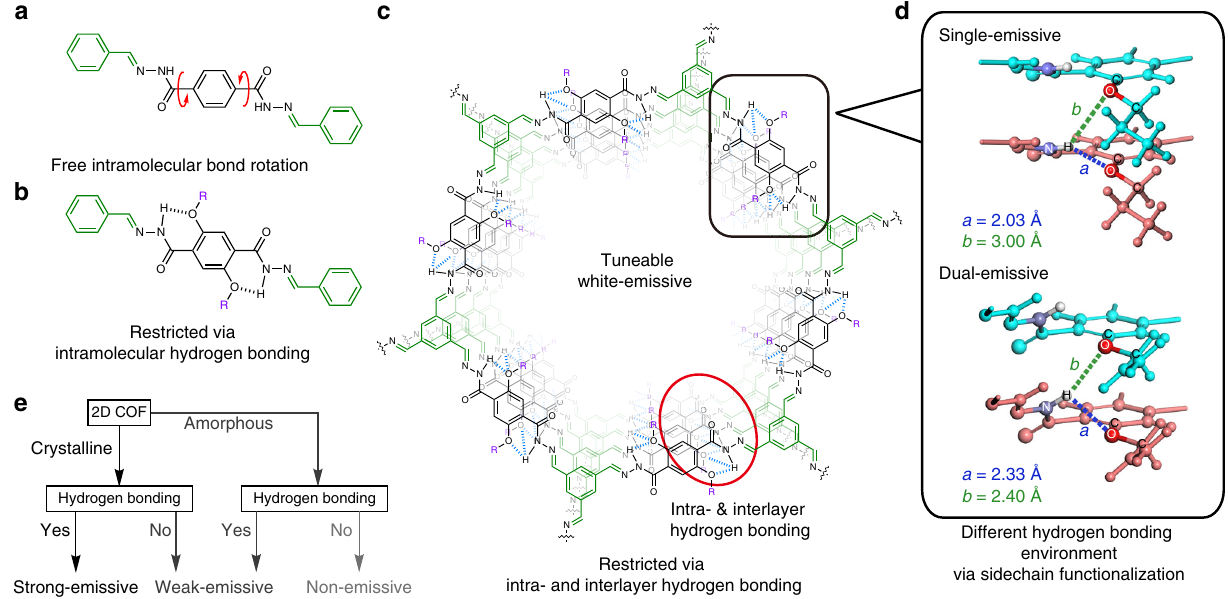
Fig. 1 Design principles of the tuneable white-emissive 2D COFs. a Intramolecular rotation in the amorphous solid state makes it non-emissive. b Intramolecular rotation is restricted via intramolecular hydrogen bonding, leading to enhanced emission in the UV to violet region. c The small building units are extended into 2D COFs and immobilized via intra- and interlayer hydrogen bonding; thus, the units display further enhanced PL in the visible region. d Intralayer hydrogen bonding competes with interlayer bonding; single emission is observed in COFs with intra- and interlayer hydrogen bonding of 2.03 Å and 3.00 Å, while dual emission is observed in COFs with intra- and interlayer hydrogen bonding of 2.33 Å and 2.40 Å, respectively (upper layer: light blue; lower layer: pink; O: red; N: violet; H: white; intralayer hydrogen bonding: blue dashed line; and interlayer hydrogen bonding: green dashed line). e Flow chart to achieve strong emission in the solid state of 2D COFs 2 NATURE COMMUNICATIONS| (2018) 9:2335 |DOI: